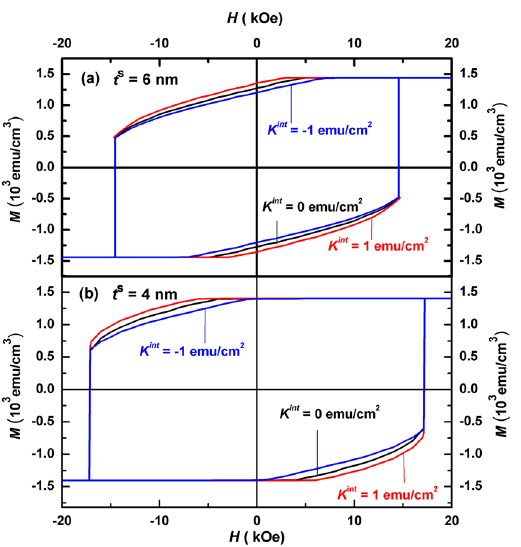
Figure 6. Calculated hysteresis loops of Nd 2 Fe 14 B (10 nm)/ α -Fe ( t s ) multilayers for various interface anisotropy. ( a ) Loops for soft layer thickness t s = 6 nm. ( b ) Loops for t s = 4